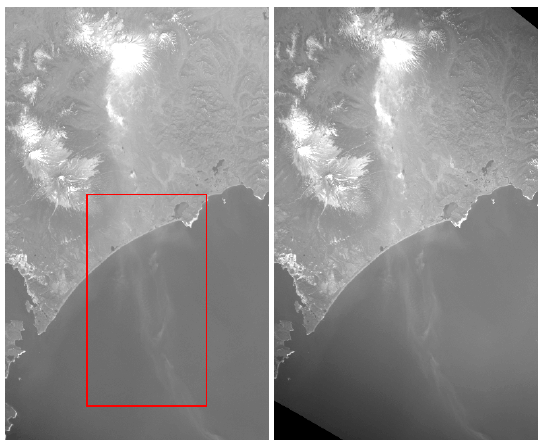
Figure 7. Geolocated green channel of the images numbered ISS041e000162 (left) and ISS041e000164 (right). The red rectangle shows the extent of results in fig. 8.